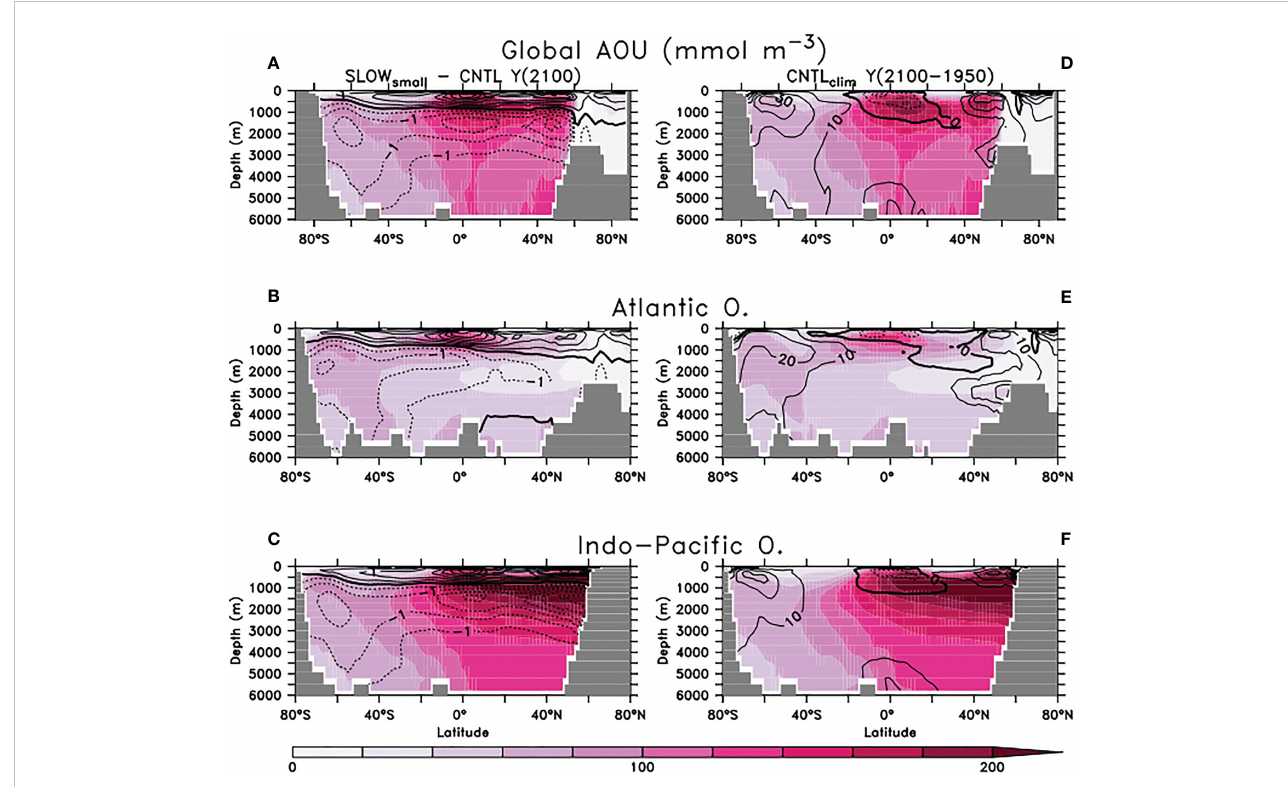
FIGURE 11 Panels (A – C) : SLOW small model ensemble zonal mean apparent oxygen utilisation (AOU) at year 2100 globally (A) , Atlantic (B) , and Indo-Paci fi c (C) . Overlaid are SLOW small - CNTL model ensemble zonal mean AOU differences in mmol O 2 m -3 . Dashed contours indicate reduced oxygen utilisation. AOU in SLOW big is provided as Supplemental Figure S5. (D – F) CNTL clim zonal mean AOU at year 2100, separated by basin as with panels (A – C) . Overlaid is the CNTL clim AOU change between years 1950 and